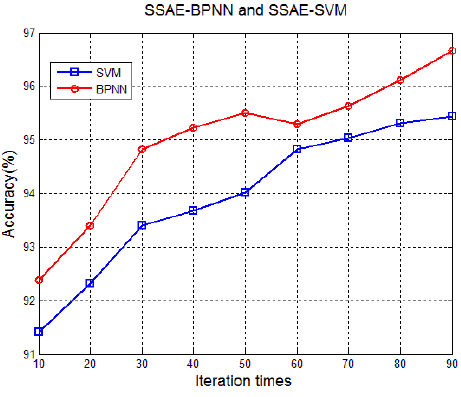
Figure 13. Comparison of SSAE-BPNN and SAE-BPNN.